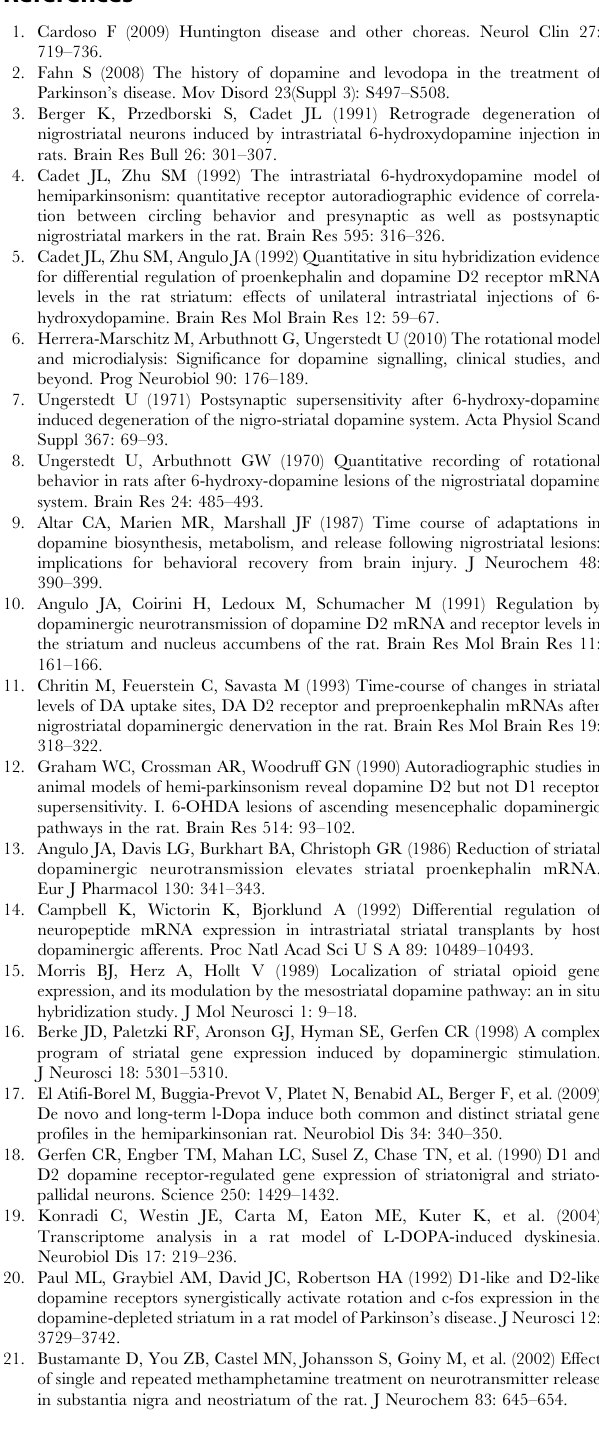
Table S1 List of rat primers used in quantitative PCR